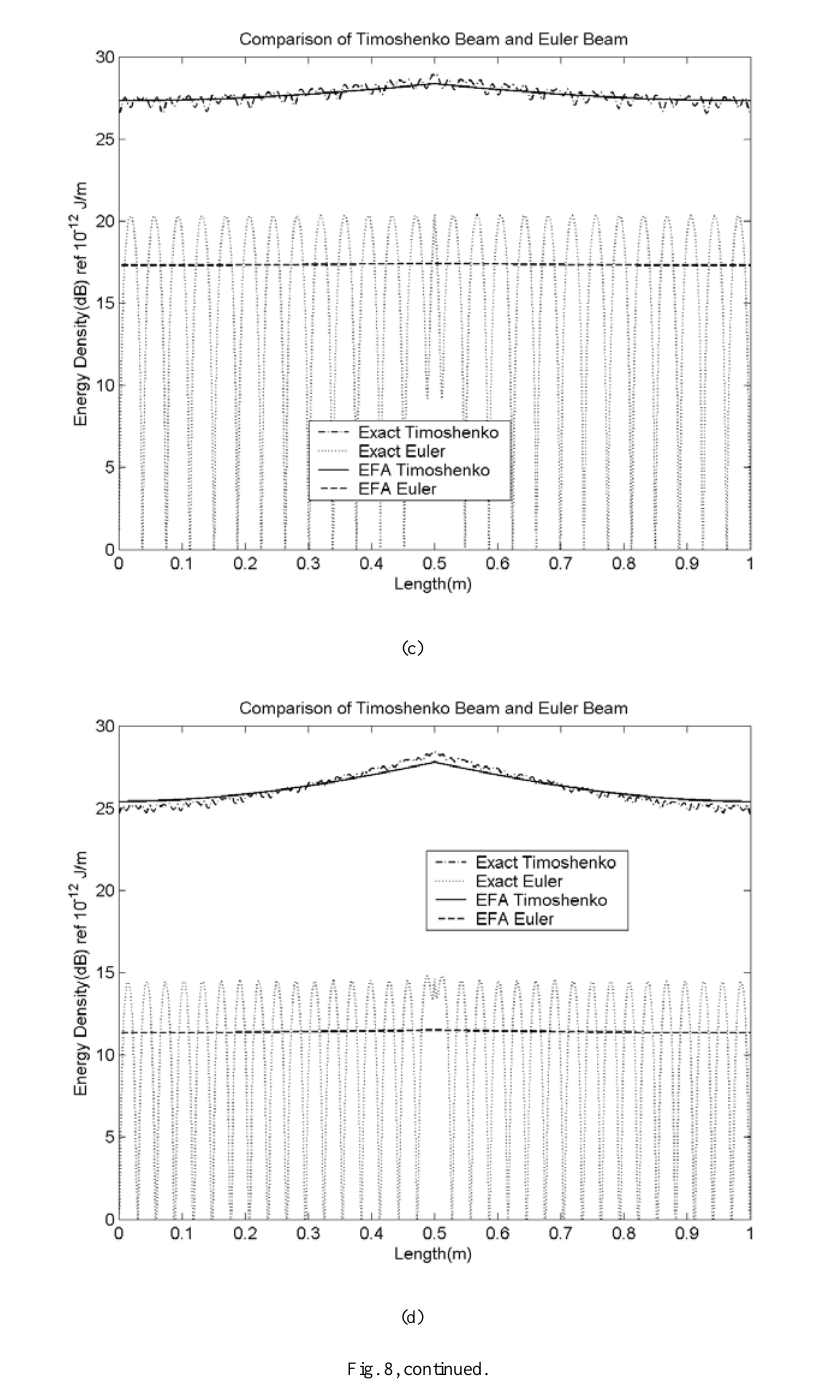
of the time- and locally space-averaged far-field energy density and power distributions of built-up structures composed of beams in the high frequency ranges if the extended researches on the coupling relationships of the Timoshenko beam are performed, which are described in the other companion